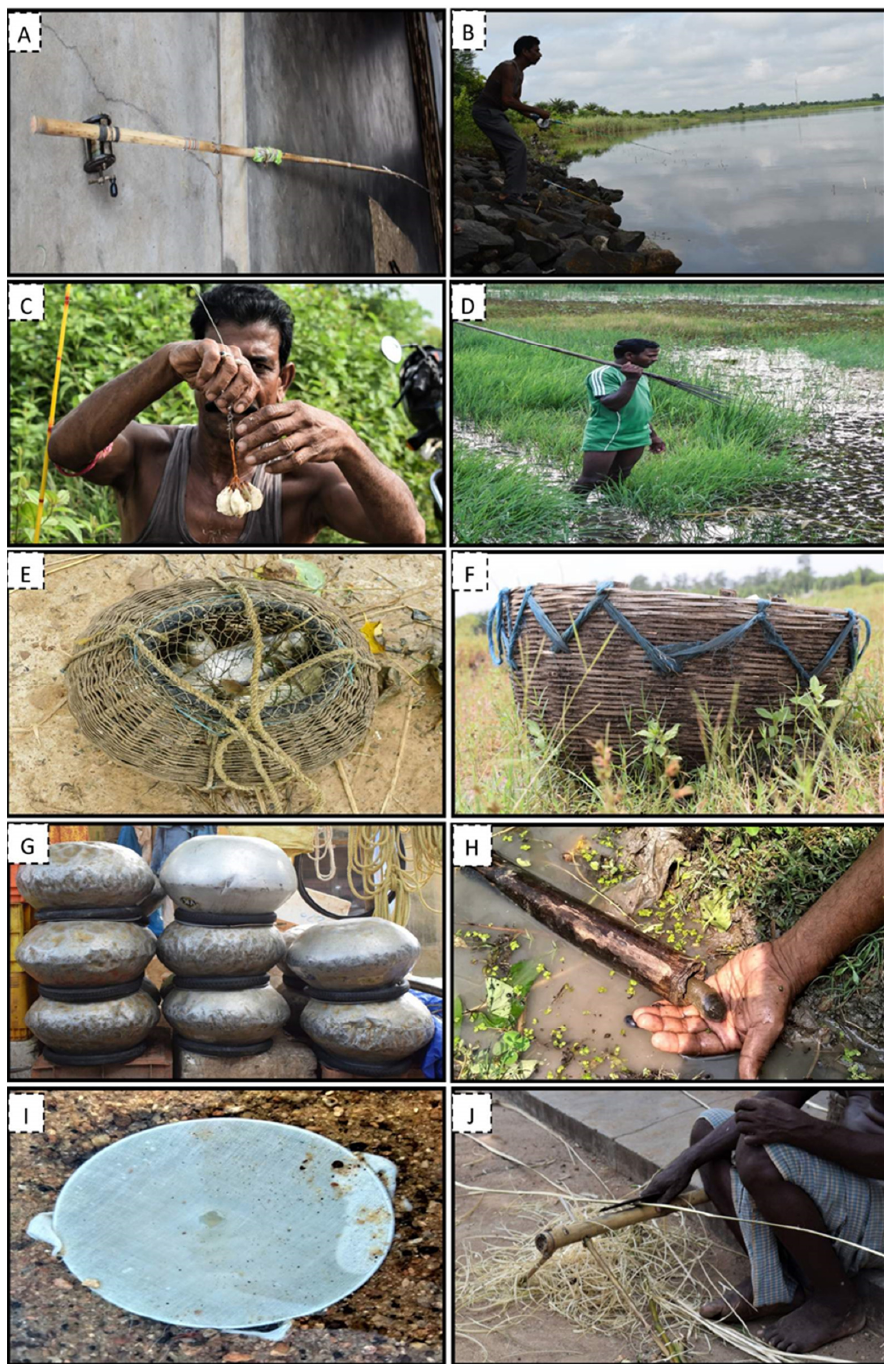
Figure 5. Traditional fishing gears: (A) Hu'ila chipa; (B) Jhima chipa; (C) Bait; (D) Kēcā; (E) Khalu'i; (F) Jhu ṛ i; (G) Hām ̐ ṛ i; (H) Bamboo piece immersion; (I) Bowl trap; (J) Bamboo slicing Hām ̐ ṛ